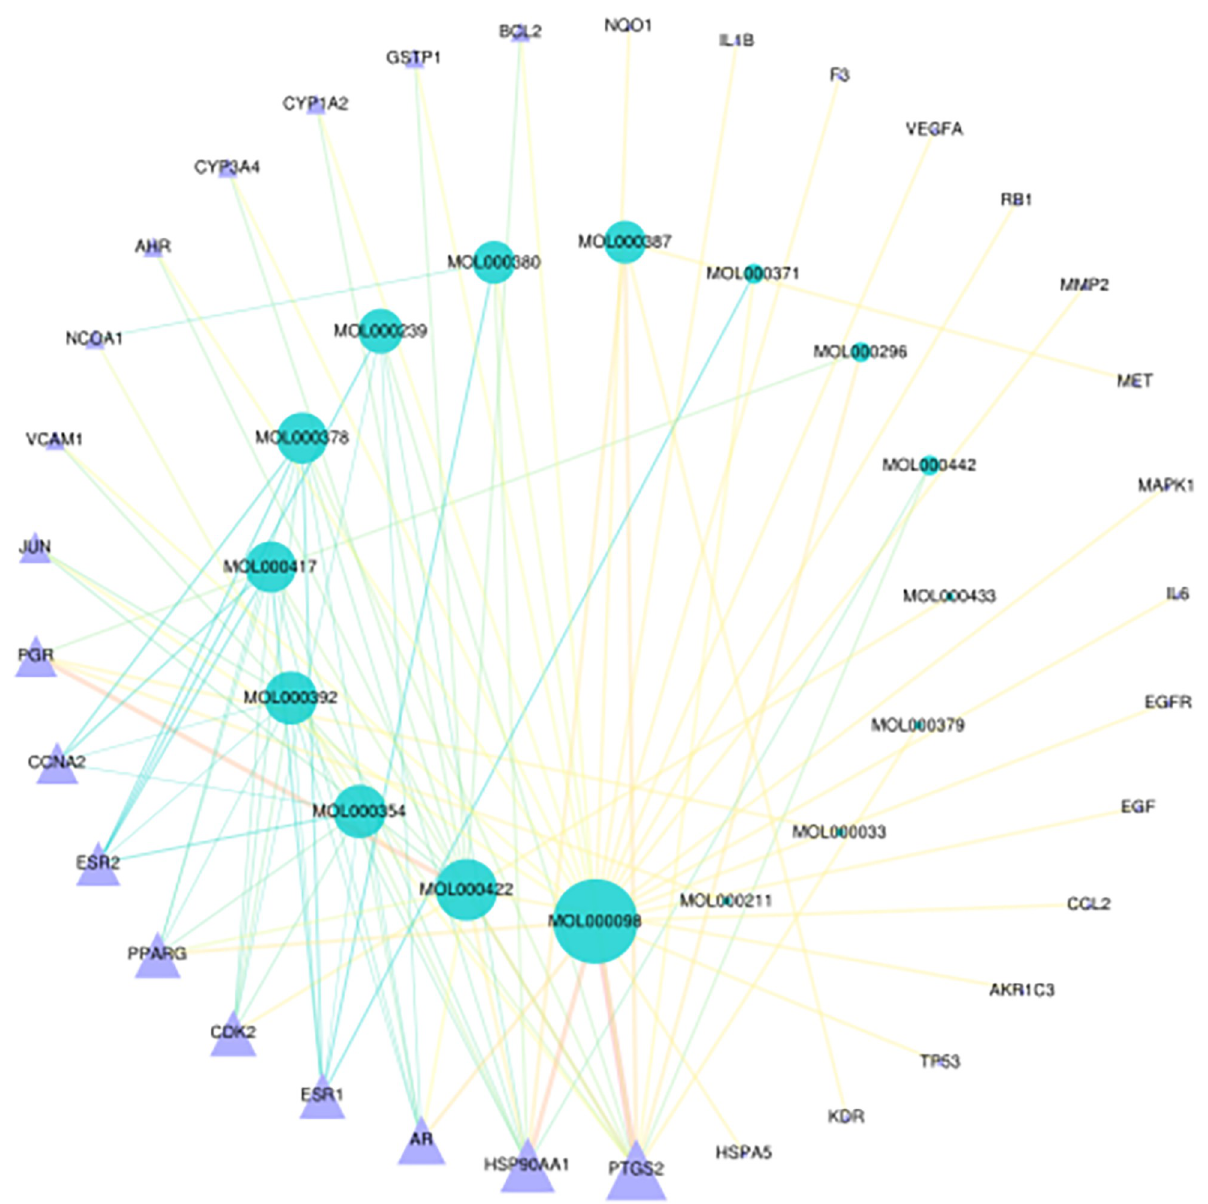
Fig 2. Compound–target network. The Compound-target network of HQ. The blue circle is the compound and the purple triangle is the target protein.